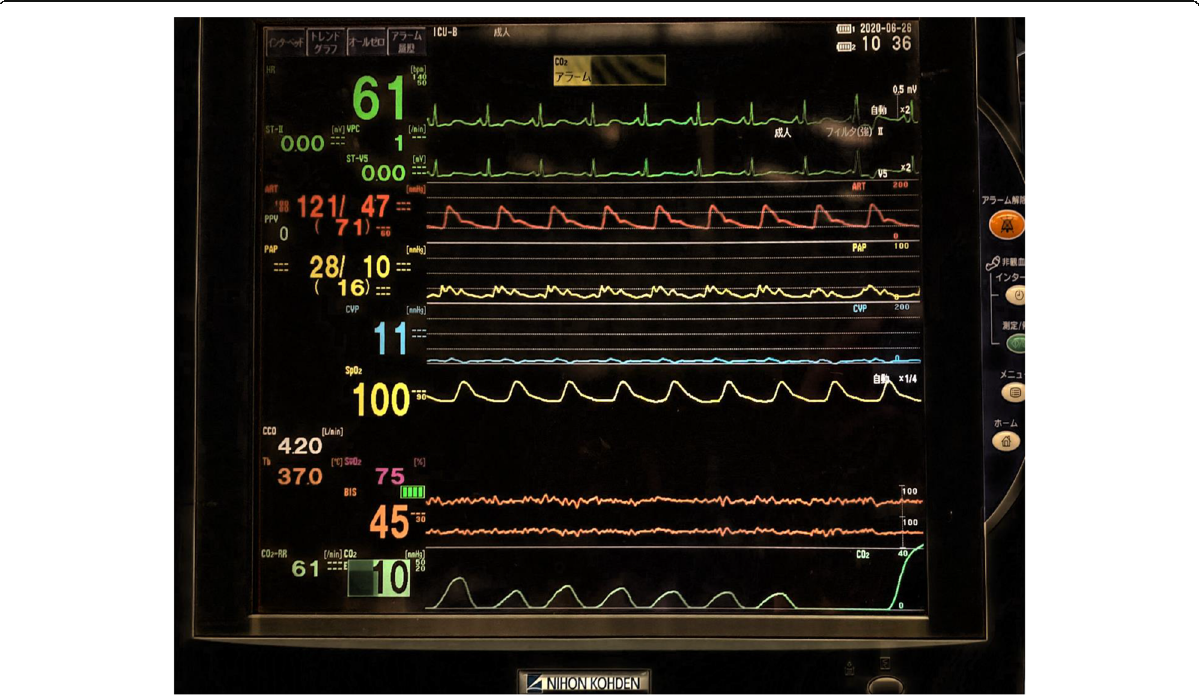
Fig. 2 The patient monitor display during the second spontaneous breathing test with pressure triggering. From top to bottom, heart rate, blood pressure, pulmonary artery pressure, central venous pressure, saturation of percutaneous oxygen, cardiac output, body temperature (left) and mixed venous oxygen saturation (right), bispectral index, and respiratory rate (left) and end-tidal carbon dioxide (right). Heart rate and respiratory rate were the same at